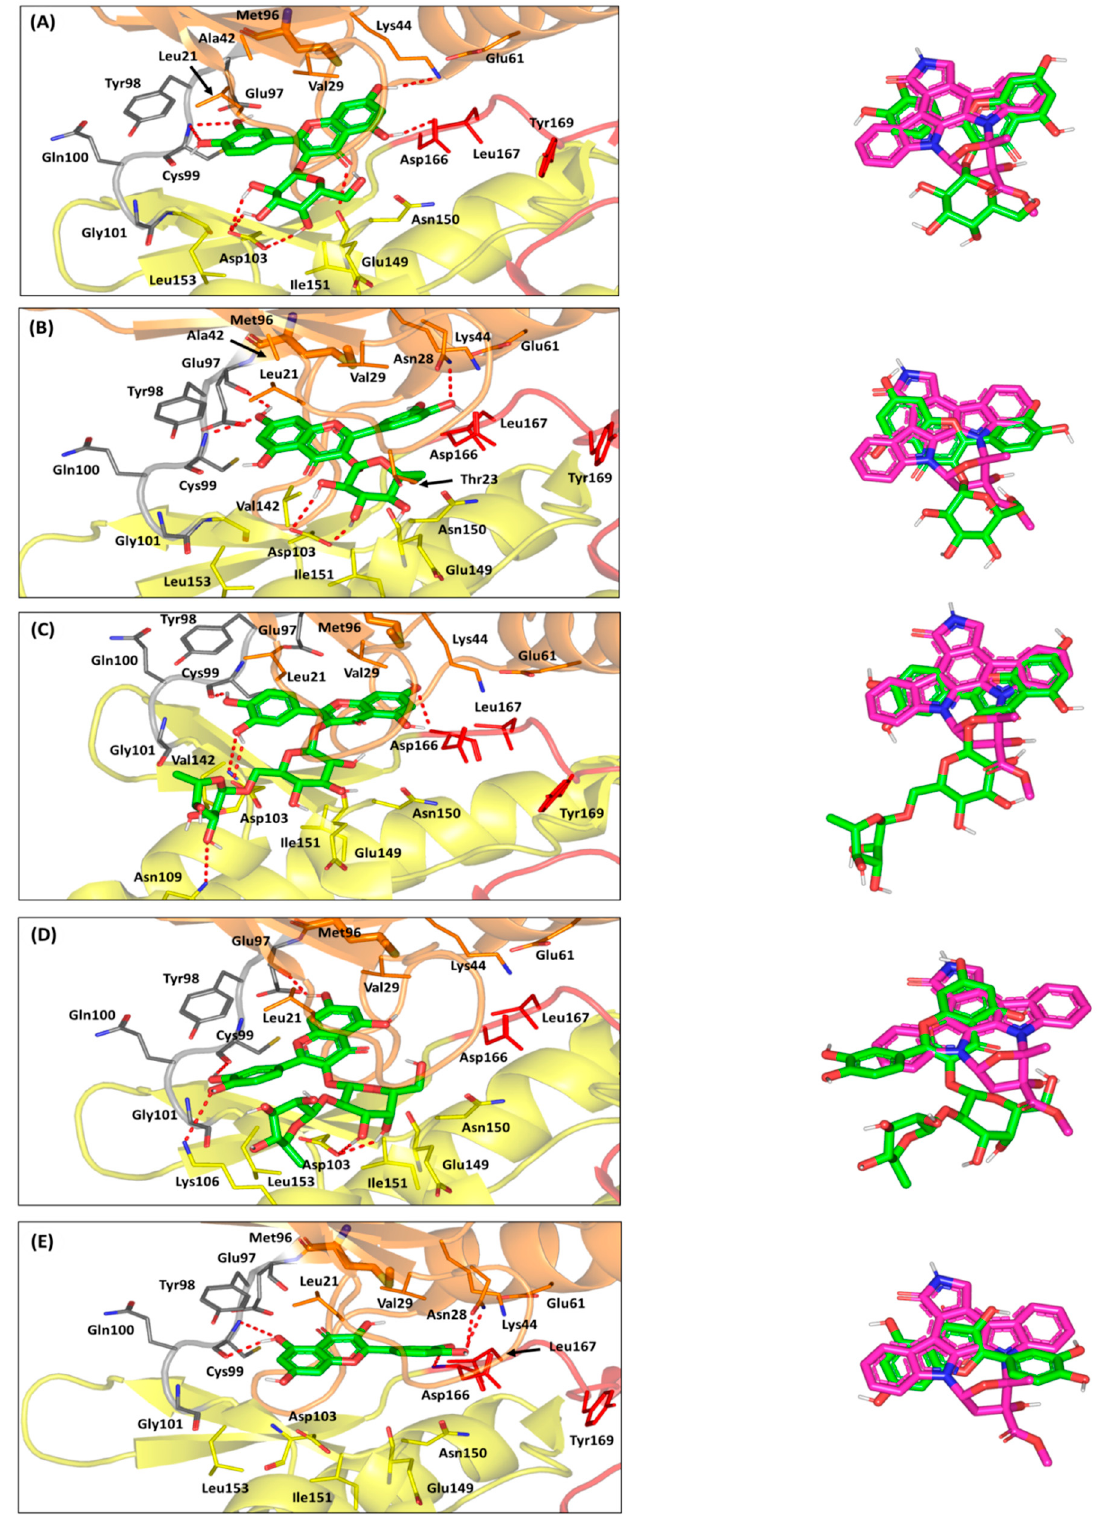
Figure 8. Molecular docking investigation of the isolated compounds at ATP-binding site of the hIKK protein target (PDB ID: 4KIK). Left panels illustrate the proposed docking poses for the investigated compounds (green sticks) at the catalyric ATP-binding site of IKK target protein (orange, yellow, gray, and red cartoons for N-lobe, C-lobe, hinge region, and activation segment, respectively); ( A ) quercetin-3- O - β -galactoside; ( B ) isoquercitrin; ( C ) rutin; ( D ) quercetin-3- O - neohesperdoside; ( E ) quercetin. On the right, overlay of docked isolated compounds (green sticks) and crystallized ligand, KSA (magenta sticks), depicting their comparative orientations within the catalytic binding site. Polar interactions,